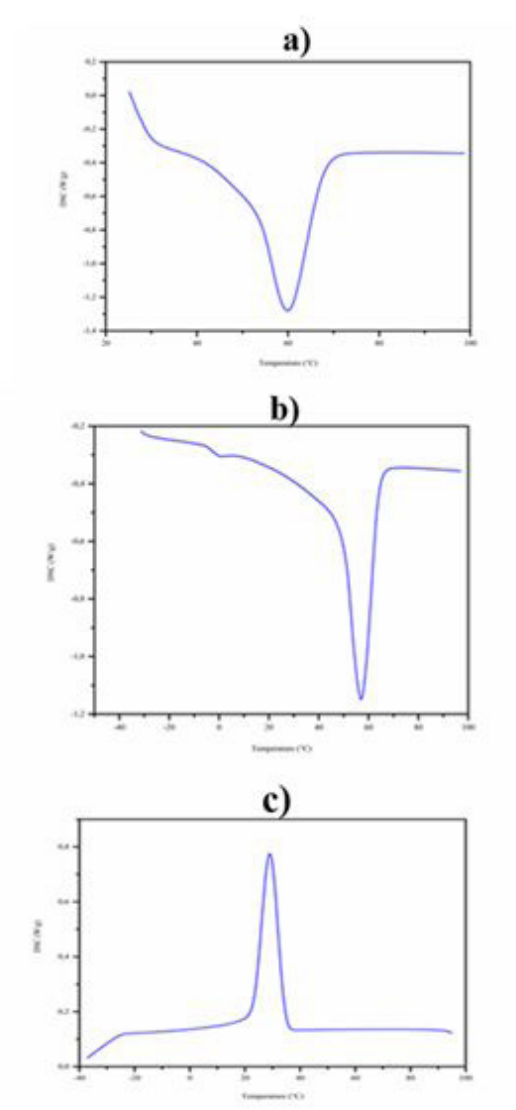
and Group 2 – Nanotubes of TiO 2